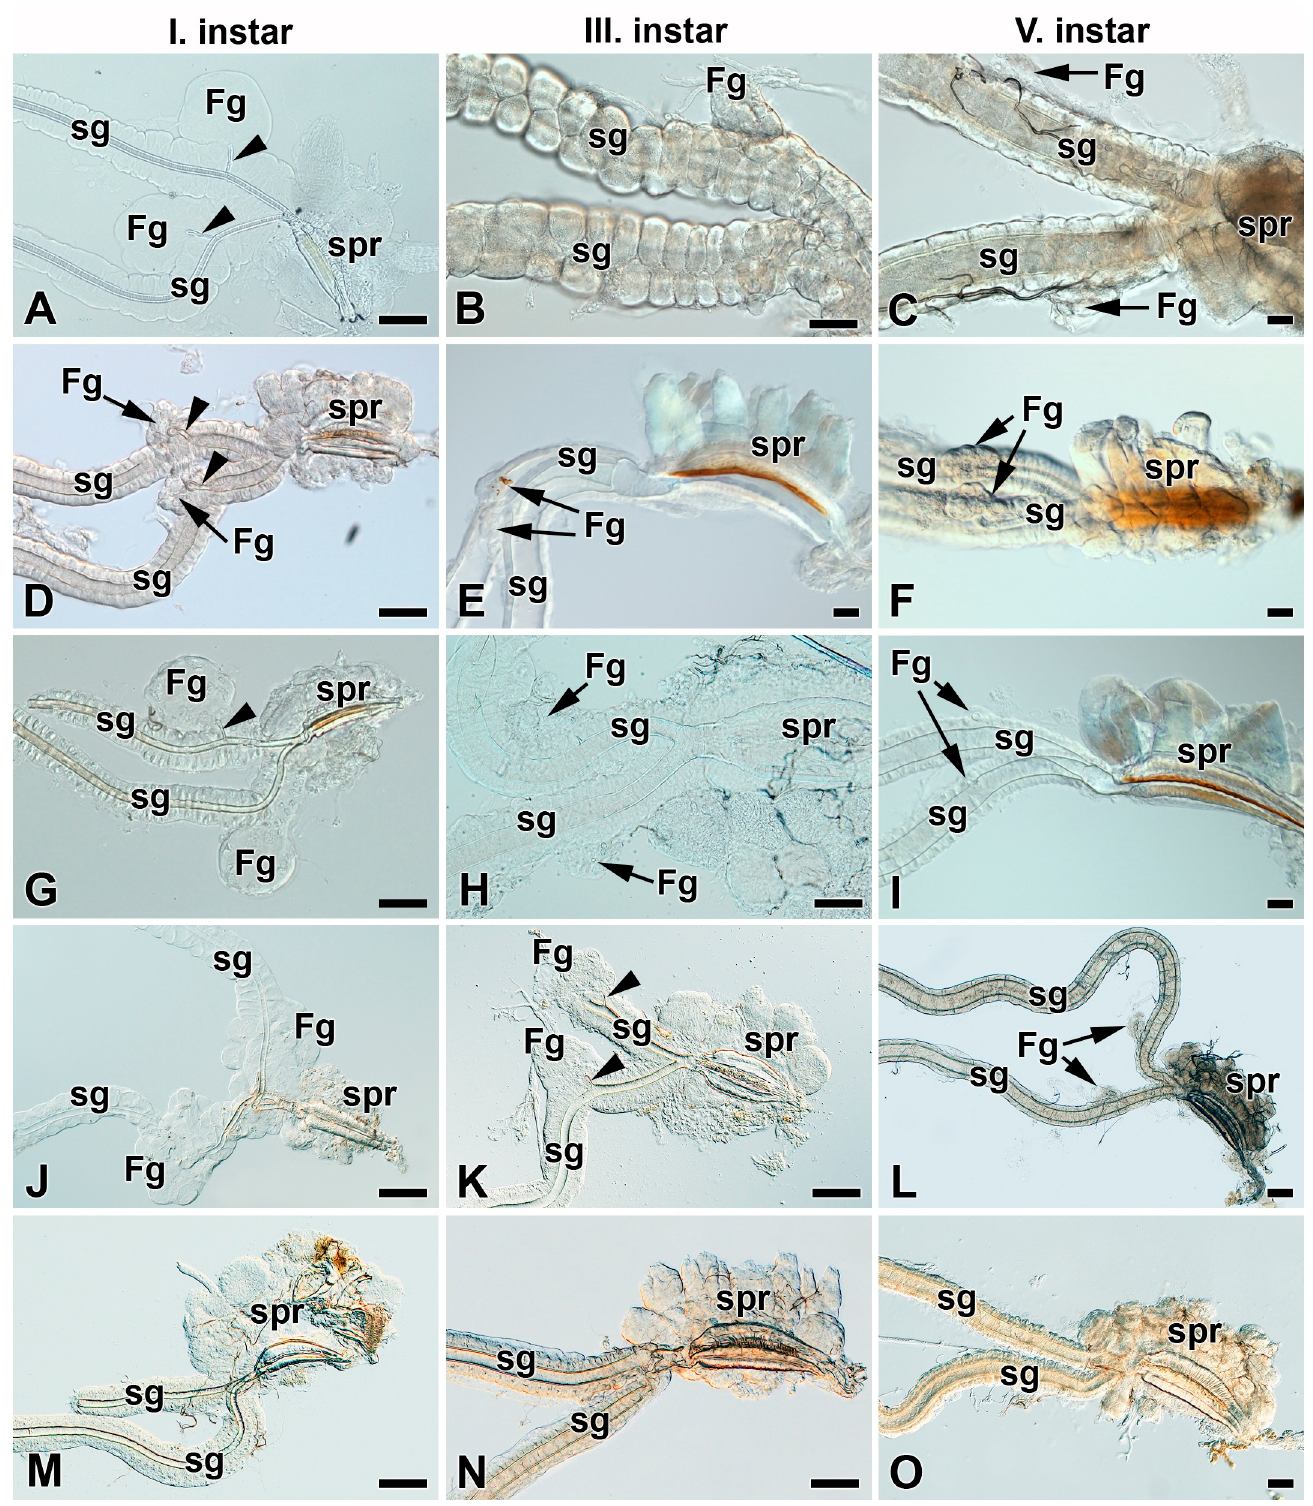
Figure 6. Development of spinning apparatuses of Sphingidae, first, third, and fifth larval instars. ( A – C ) Bedstraw hawk moth, Hyles gallii. ( D – F ) Death’s-head hawk moth, Acherontia atropos . ( G – I ) Privet hawk moth, Sphinx ligustri. ( J – L ) The eyed hawk moth, Smerinthus ocellatus . ( M – O ) The poplar hawk moth, Laothoe populli . The FGs are shown by arrows. The arrowheads indicate the ducts of the FGs entering the lumen of the SGs. Abbreviations: Filippi’s gland (Fg), silk gland (sg), and silk press of the spinning apparatus (spr). Scale bars: 50 μ m.